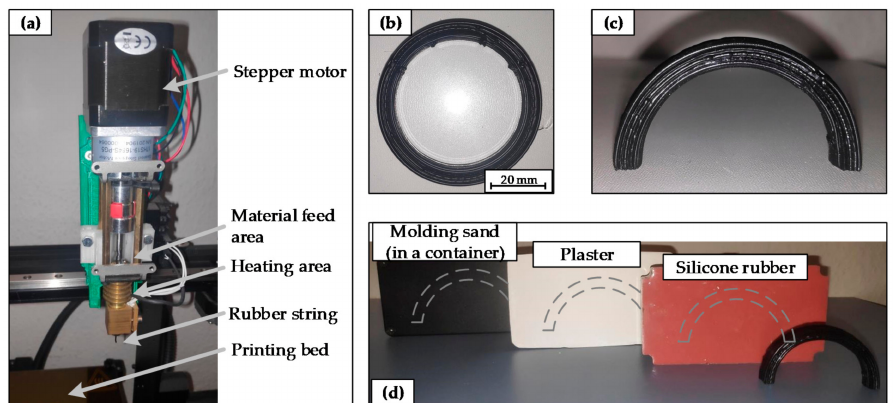
Figure 3. ( a ) Screw extruder for the additive manufacturing for rubber compounds; ( b ) additive manufactured rubber disc, ( c ) unvulcanized arc sample for the vulcanization tests, and ( d ) in MDS embedded arc samples for the vulcanization